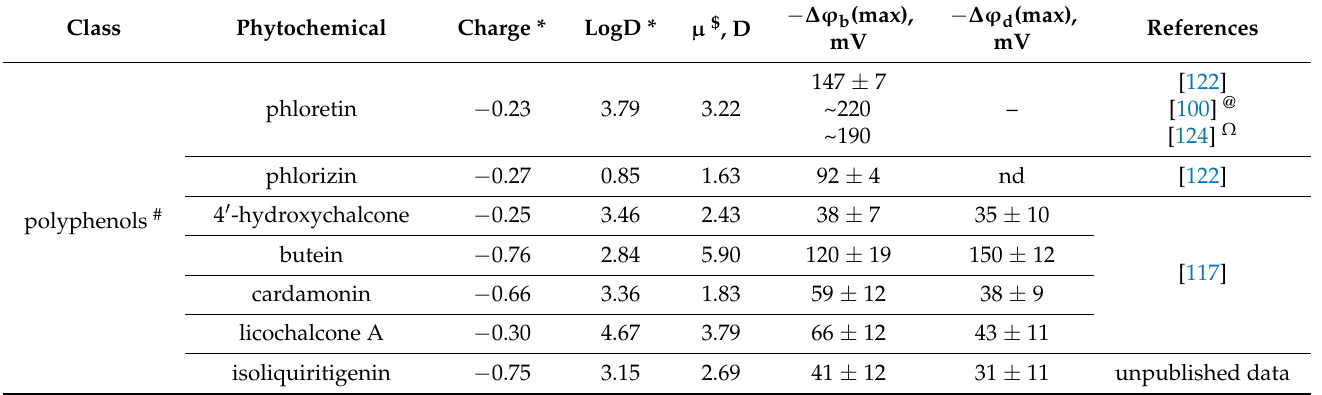
Table 1. The quantitative characteristics of phytochemical-induced alteration in the membrane boundary and dipole potential.